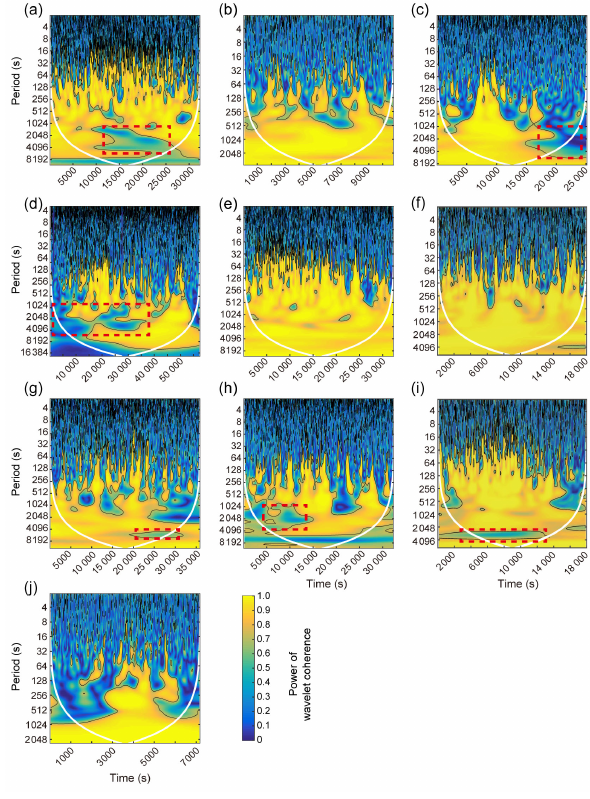
Figure 3. Coherence analyses between the space charge density and dust concentration. (a–j) Squared wavelet coherences, in turn, cor- respond to dust storms nos. 1–10 presented in Table 1. The 5% sig- nificance level, estimated by Monte Carlo methods (Grinsted et al., 2004), against red noise is shown as black contour lines. The cone of influence where edge effects might distort the signal is shown as a white line. The relative phase relationship between the two time series is shown in Figs. S9–S13. Dashed rectangular boxes denote the destructions of large-scale electrification equilibrium at some